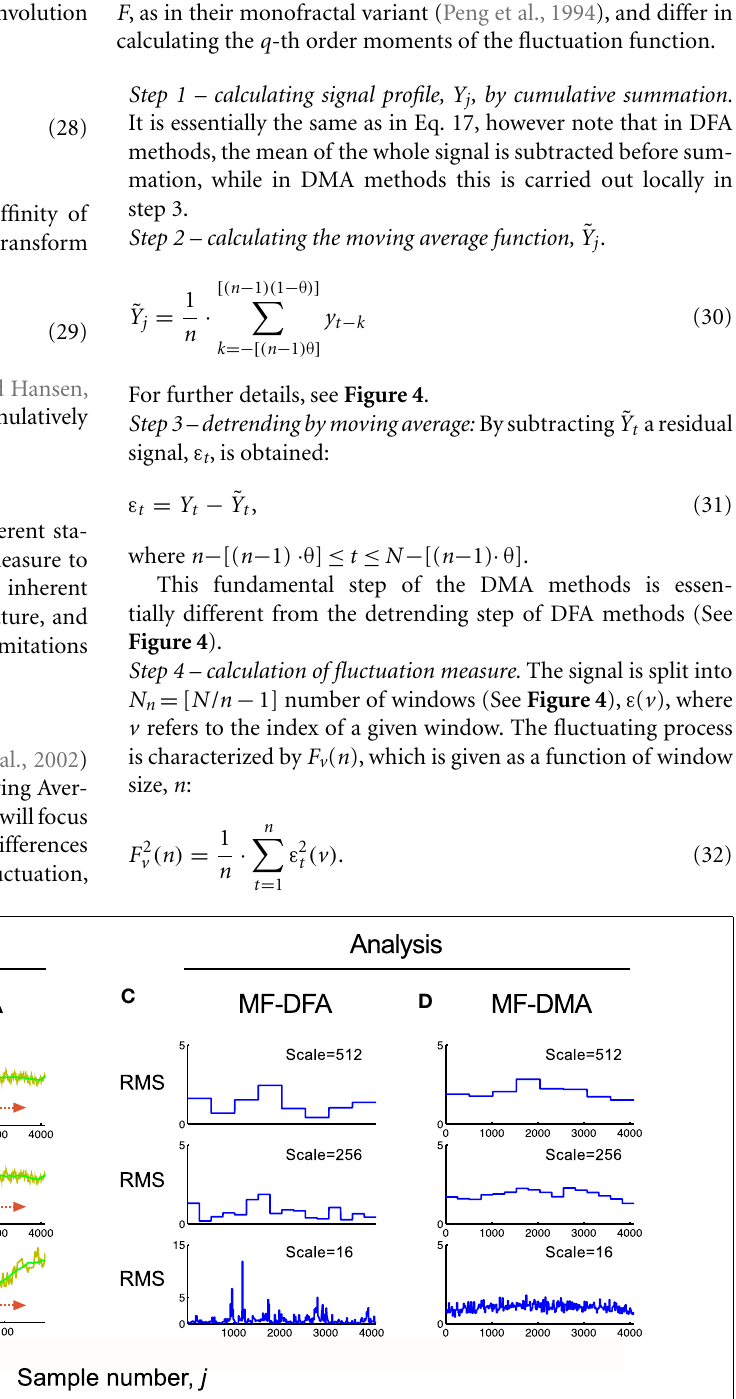
FIGURE 4 | Detrending scheme and fluctuation analysis for MF-DFA and MF-DMA methods. The detrending strategy for MF-DFA (A) is that the signal is divided into a set of non-overlapping windows of different sizes, and a local low-order polynomial (typically linear) fit (shown in green) is removed from each window’s data. In contrast, MF-DMA (B) removes the moving average point-by-point calculated in different window sizes around the processed point with a position given by θ .This parameter describes the delay between the moving average function and the original signal. Its value is taken from [0, 1]